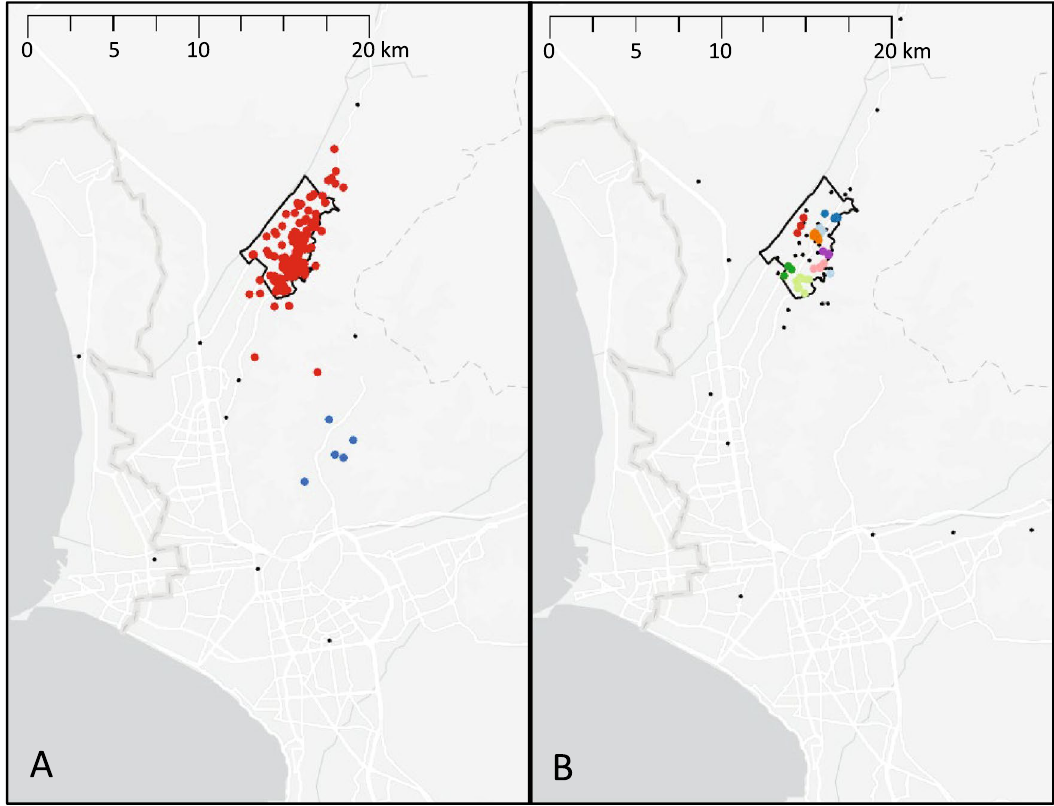
Figure 1. Density-based clustering of locations where participants reported having lived, slept, or spent the majority of the day during the past 6 months. Each dot represents a location reported by a study participant, with colors representing clusters and black dots representing non-clustered locations. The black outline indicates the study area. Reported locations mainly clustered in the study area for both ( A ) TB patients (red dots) and ( B ) control group participants (microclusters shown in different colors). Map was created by MBB using ArcGIS Pro Version 2.8.0 (Environmental Systems Research Institute, Redlands, California,